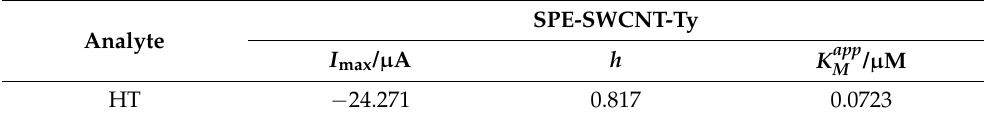
Table 4. Characteristic parameters of SPE-SWCNT-Ty for